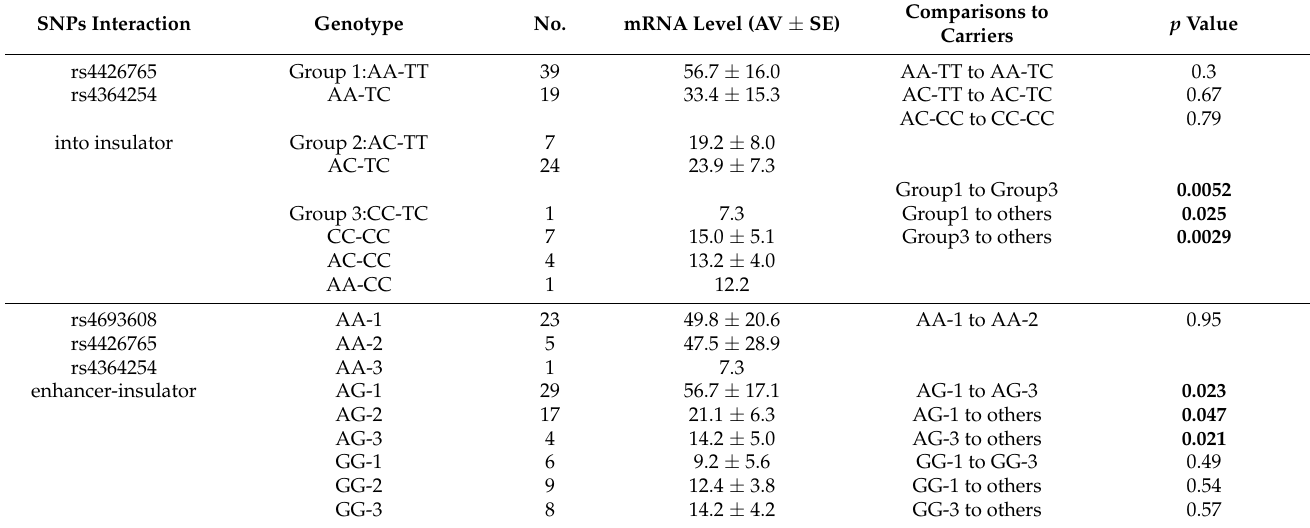
Table 5. rs4693608, rs4426765, and rs4364254 interaction in healthy individuals after LPS